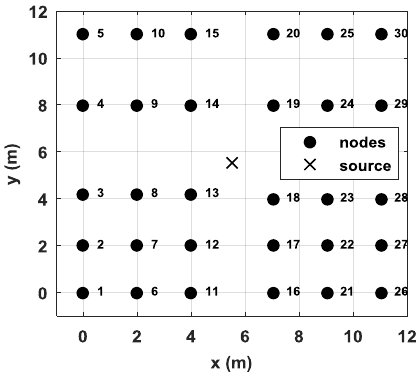
Figure 10. Node placement for the 35-node network.